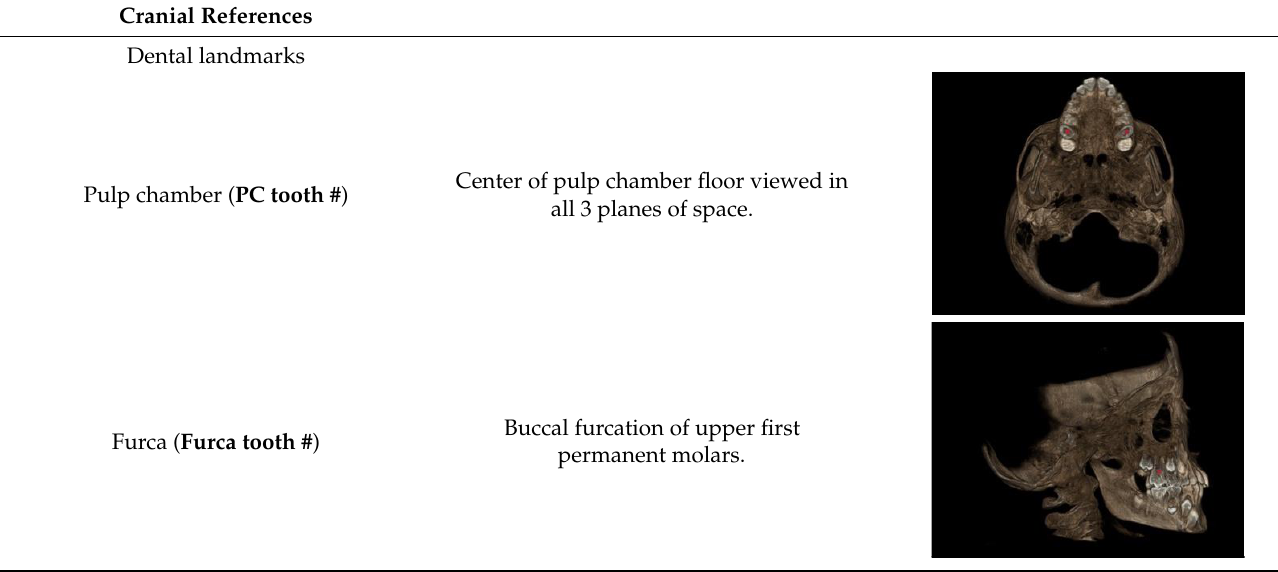
Table 2. Skeletal and dental linear measurements and their definition.